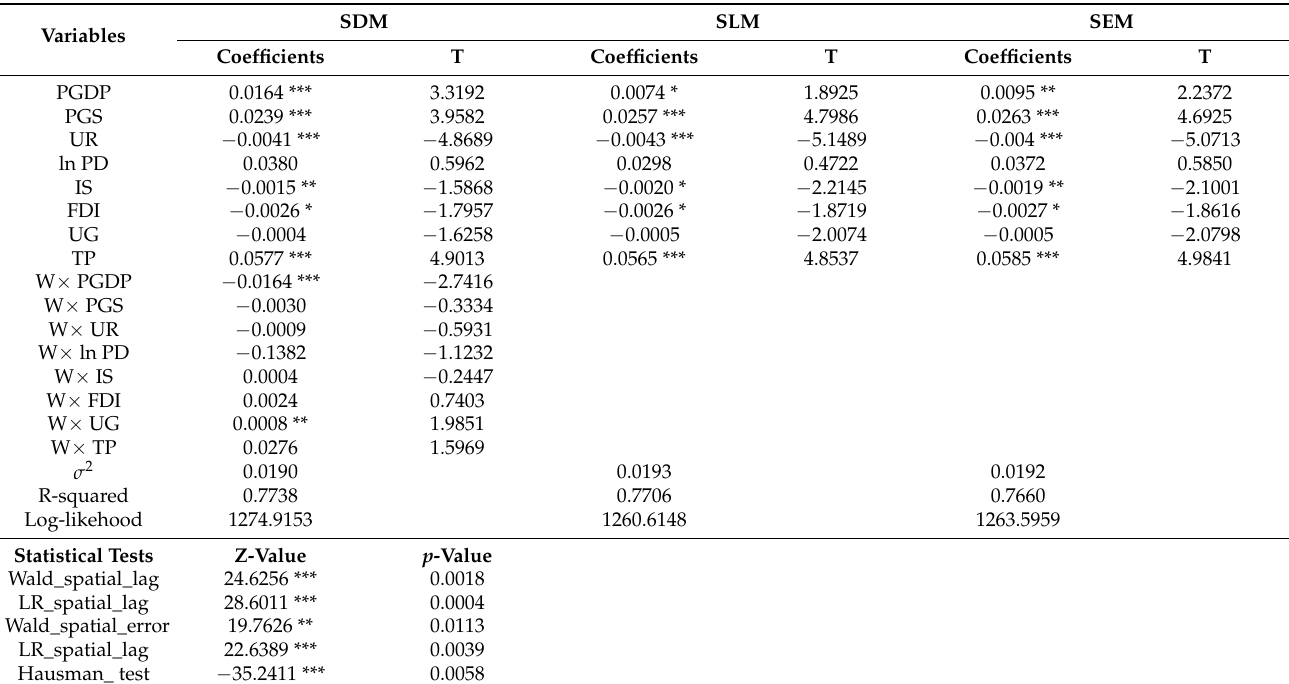
Table 7. The analysis results of robustness